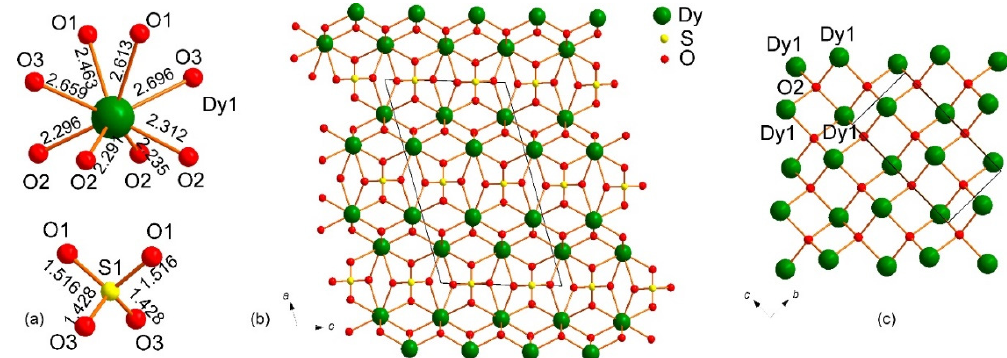
Figure 4. Cation coordination in the structure of [Dy 2 O 2 ]SO 4 ( a ). General projection of the crystal structure of [Dy 2 O 2 ]SO 4 along the b axis ( b ). [Dy 2 O 2 ] 2+ layer ( c ).